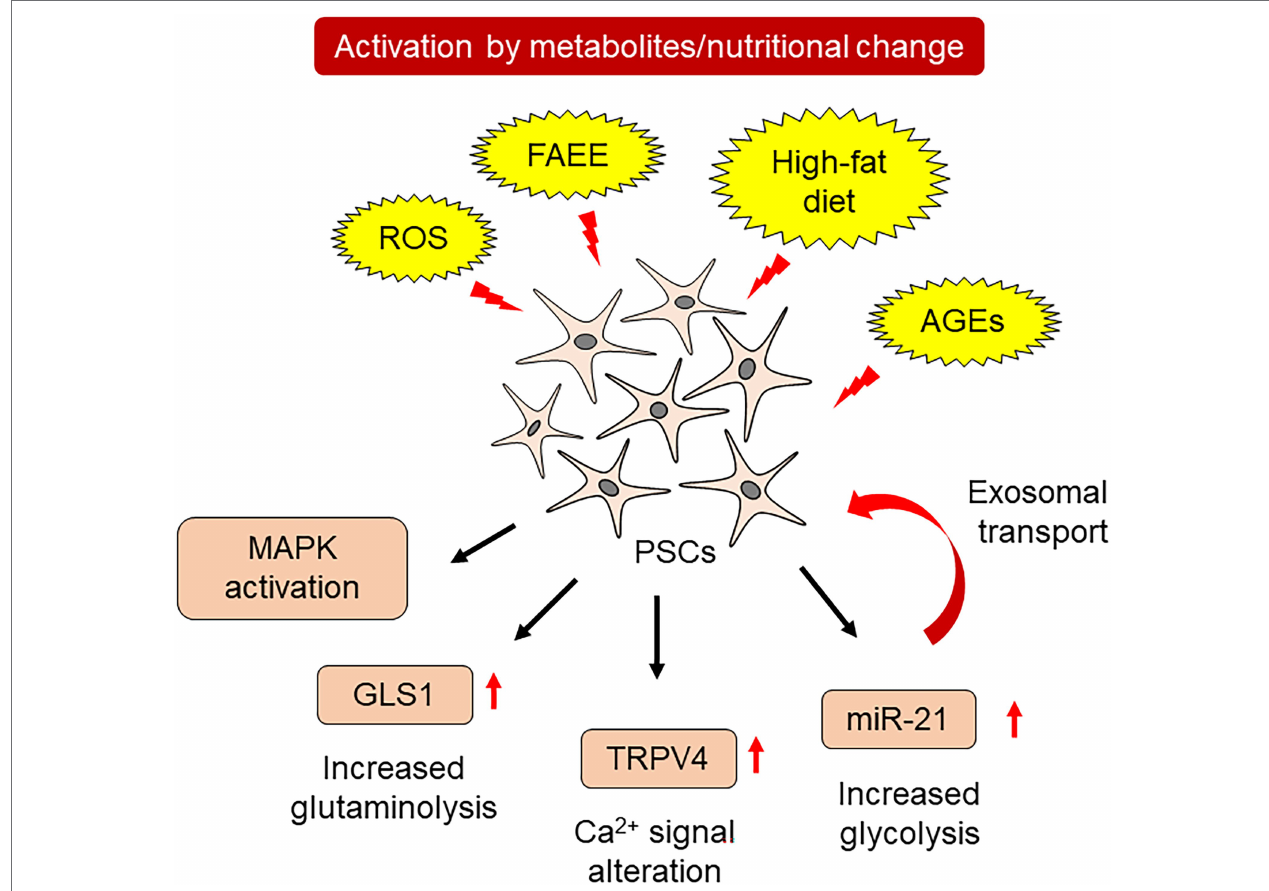
FIGURE 2 | Metabolic changes and PSC